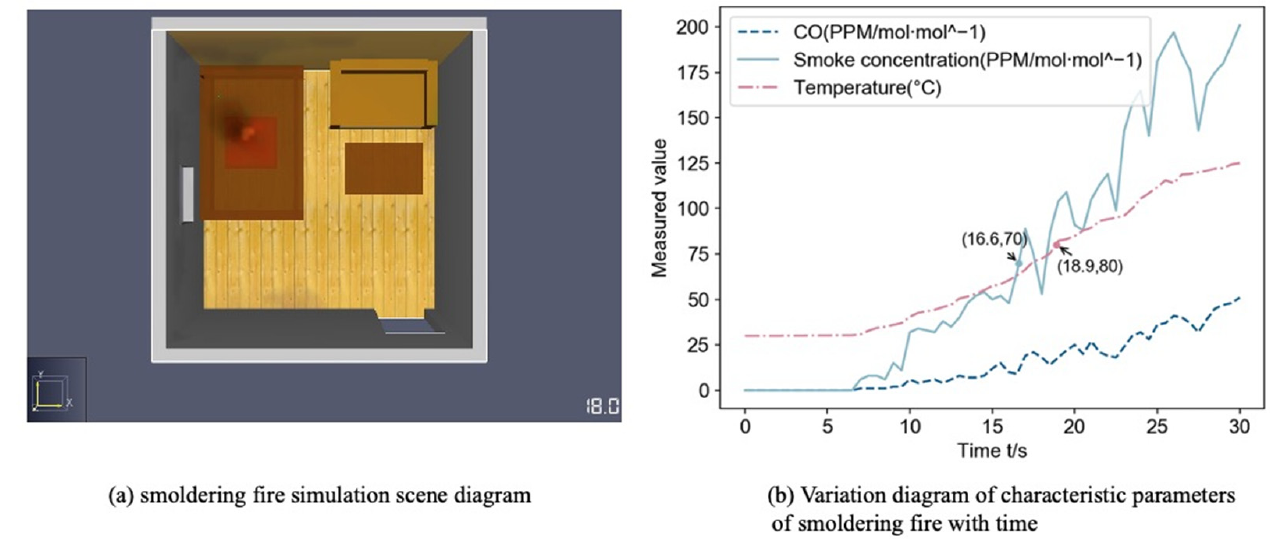
Figure 10. Smoldering fire simulation information diagram.